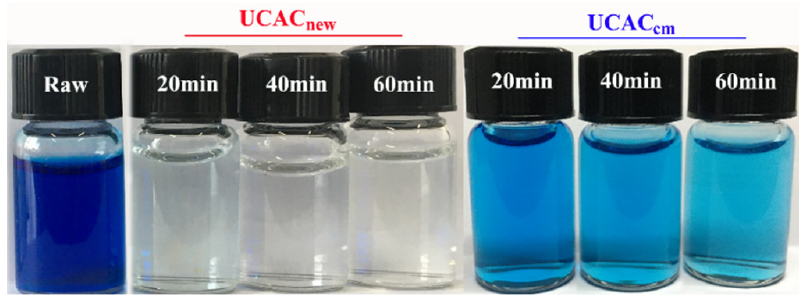
Figure 6. The adsorption results of UCAC new and UCAC cm.